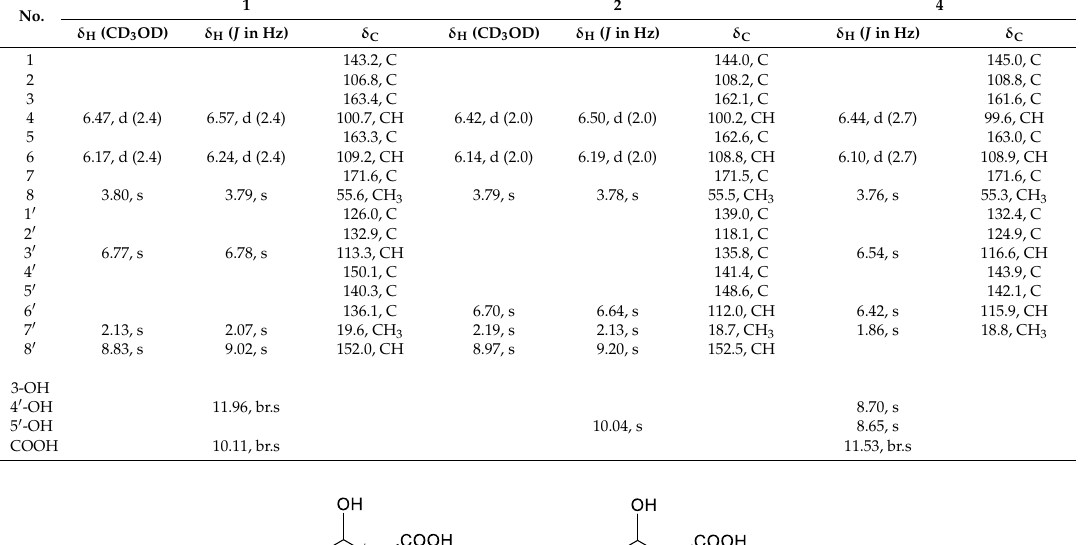
Table 1. 1 H and 13 C NMR data for 1 , 2 , and 4 (500/125 MHz, in DMSO, δ ppm, J in Hz).